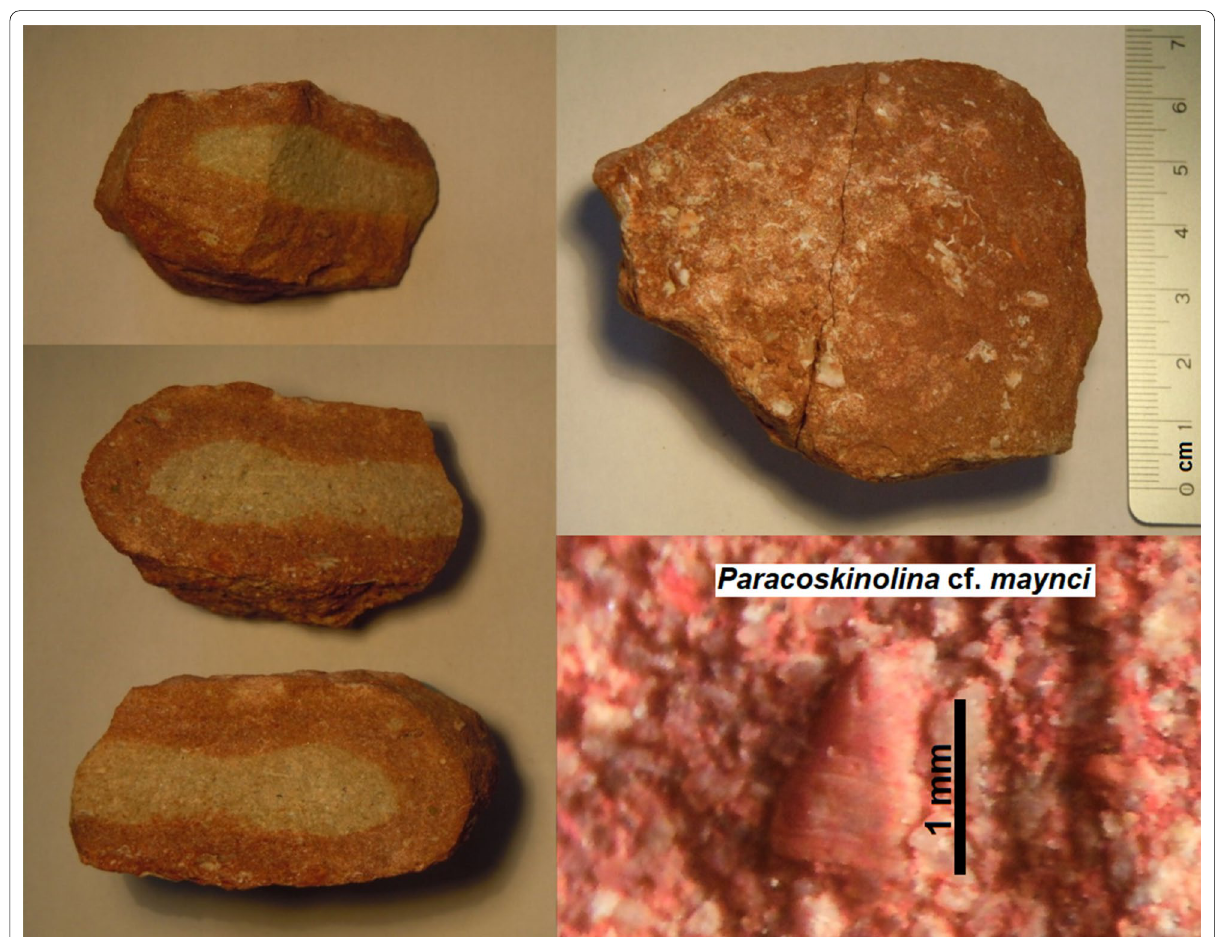
Fig. 2 Reworked pebble of Urgonien Blanc facies (whitish bioclastic packstone with detrital quartz and glauconite of the upper Vallorbe Formation) from the Eocene paleokarst infilling of Alfermée (Canton Bern) described by Renz (1936). External part of the sample characterized by thick red halo of deep impregnation with iron hydroxides after very long stay in ferruginous “terra rossa” of paleosols and karst cavities, and weathered surface of alteration with loose micritized Late Barremian orbitolinid Paracoskinolina cf. maynci (Chevalier, 1961) of approximately 1.3 urchins and fragments of small oysters. Collection and photos P.‑O. Mojon with field binocular stereomicroscope Leitz and Nikon Coolpix